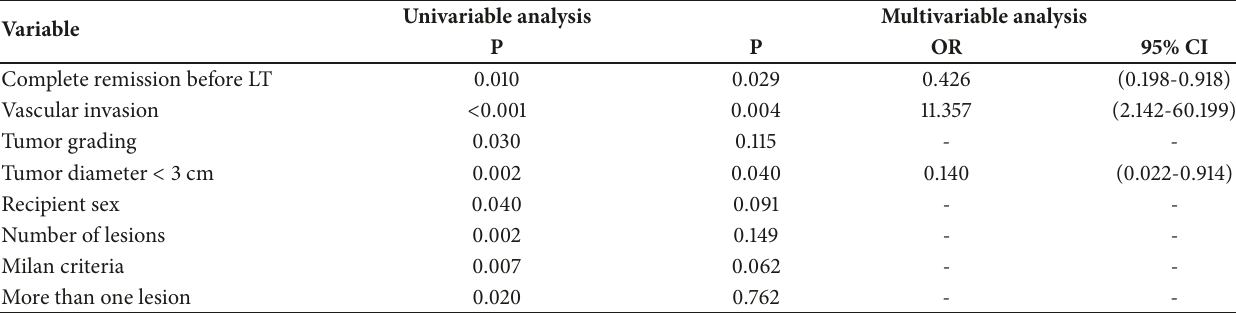
Table 2: Results of univariable and multivariable